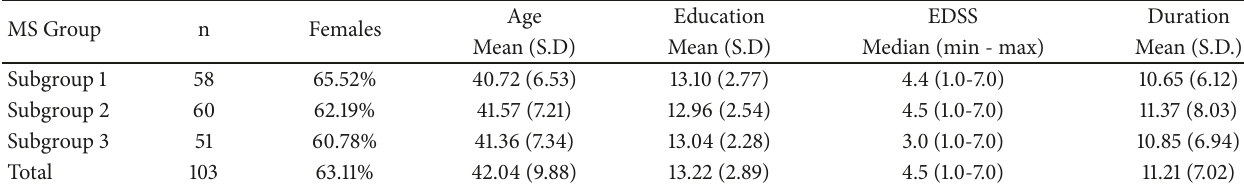
Table 1: Demographic characteristics and clinical data for MS subgroups and total MS group.